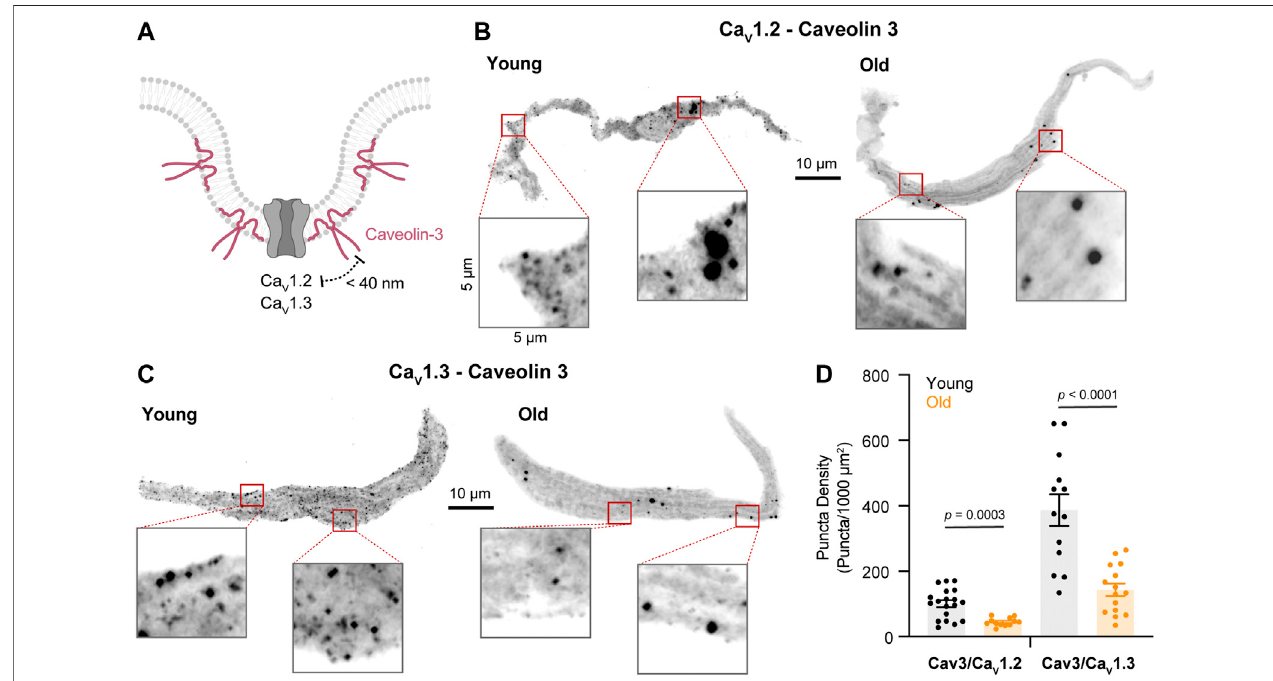
FIGURE6| AgingdecreasestheassociationbetweenL-typecalciumchannelsandcaveolin-3. (A) Diagrammaticrepresentationofthemolecularassociationbeing tested between caveolin-3 and speci fi c LTCCs. Diagram created with BioRender.com. (B) Representative PLA pictures between caveolin-3 and Ca V 1.2 channels in young and old pacemaker cells. (C) Representative PLA pictures between caveolin-3 and Ca V 1.3 channels in young and old pacemaker cells. (D) Comparison of the puncta density formed by the association ofcaveolin-3 with speci fi cLTCCsin young(Ca V 1.2 n = 19cells, Ca V 1.3 n = 13cells, and N= 3 mice) and old (Ca V 1.2 n = 12 cells, Ca V 1.3 n = 15 cells, and N = 3 mice). Statistical comparison used an unpaired t-test with signi fi cance at p <